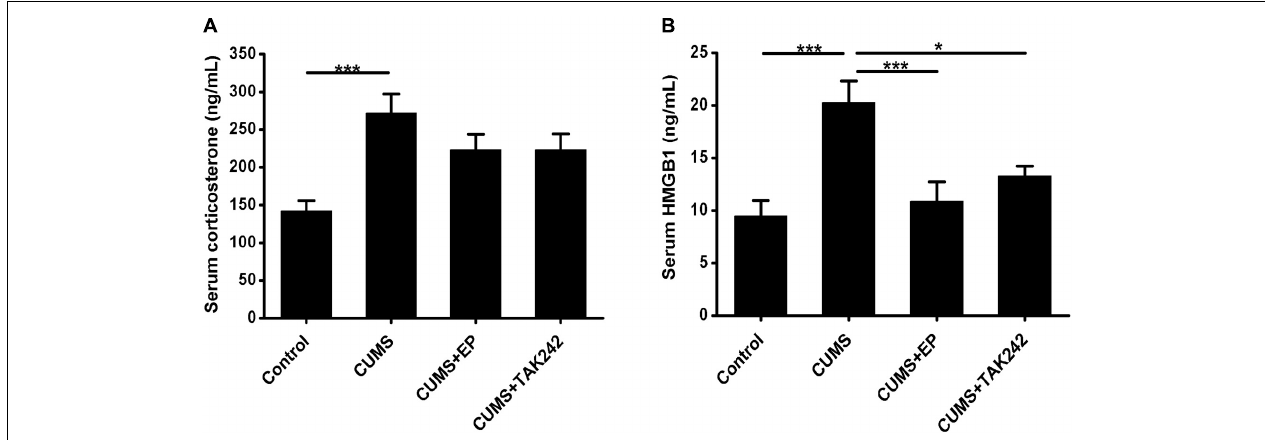
FIGURE 1 | Effect of EP and TAK-242 treatment on serum corticosterone concentrations and HMGB1 protein levels in CUMS ApoE − / − mice. ApoE − / − mice were injected with vehicle (PBS), EP (50 mg/kg, once daily), or TAK-242 (0.3 mg/kg, twice a week) for consecutive 16 weeks by intraperitoneal injection 30 min prior to CUMS. Over a 16-week period treatment, blood samples were collected for assessment of corticosterone and HMGB1 contents. (A) Serum corticosterone profiles. Corticosterone levels in serum were determined by using commercially available reagent kits. (B) HMGB1 protein levels in serum were measured by ELISA. Data were expressed as mean ± SEM ( n = 15). Statistical analysis was performed by Student’s t -test or one-way analysis of variance. ∗ P < 0.05, ∗∗∗ P < 0.001.